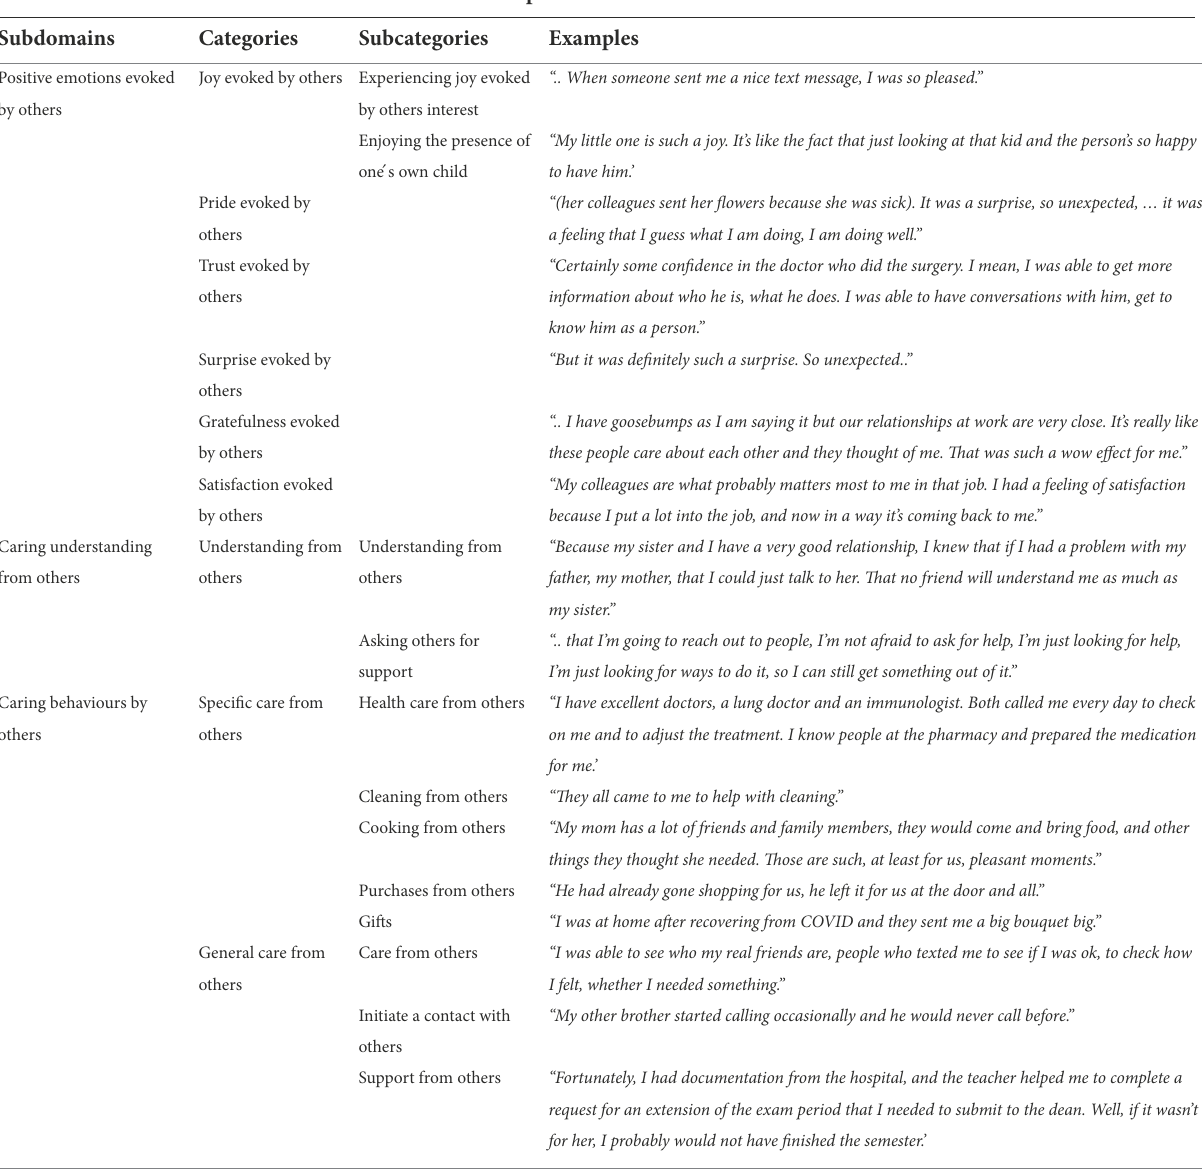
Compassion from